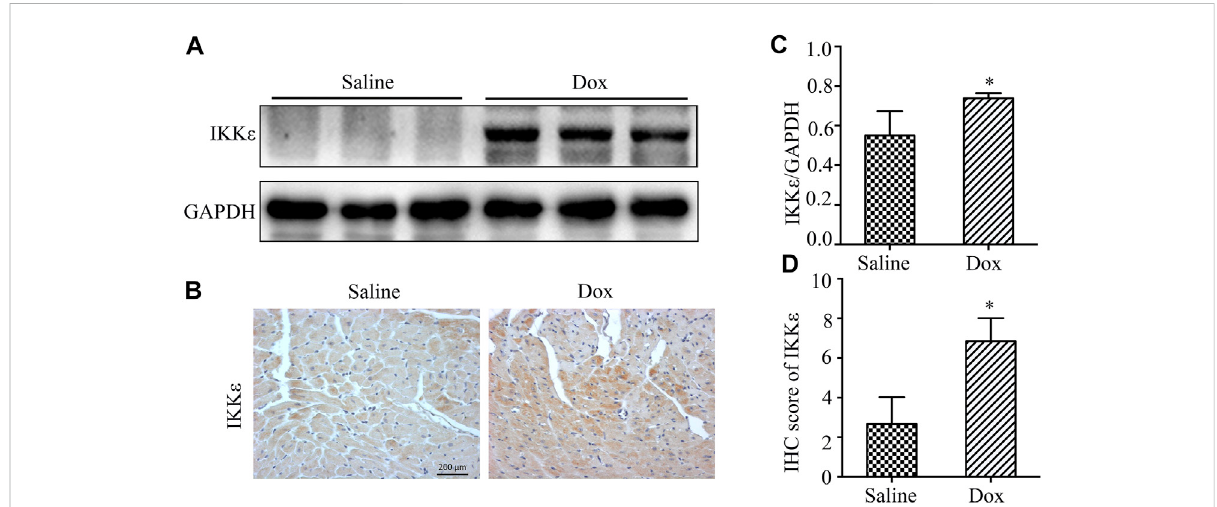
FIGURE 1 The expression of IKK ε was increased in WT mice ’ hearts after injection of Dox (A) . Representative western blot showing expression of IKK ε in heart tissue after Dox injection ( n = 4 mice per experimental group). (B) . Representative images of IHC staining of IKK ε in WT mice ’ hearts after